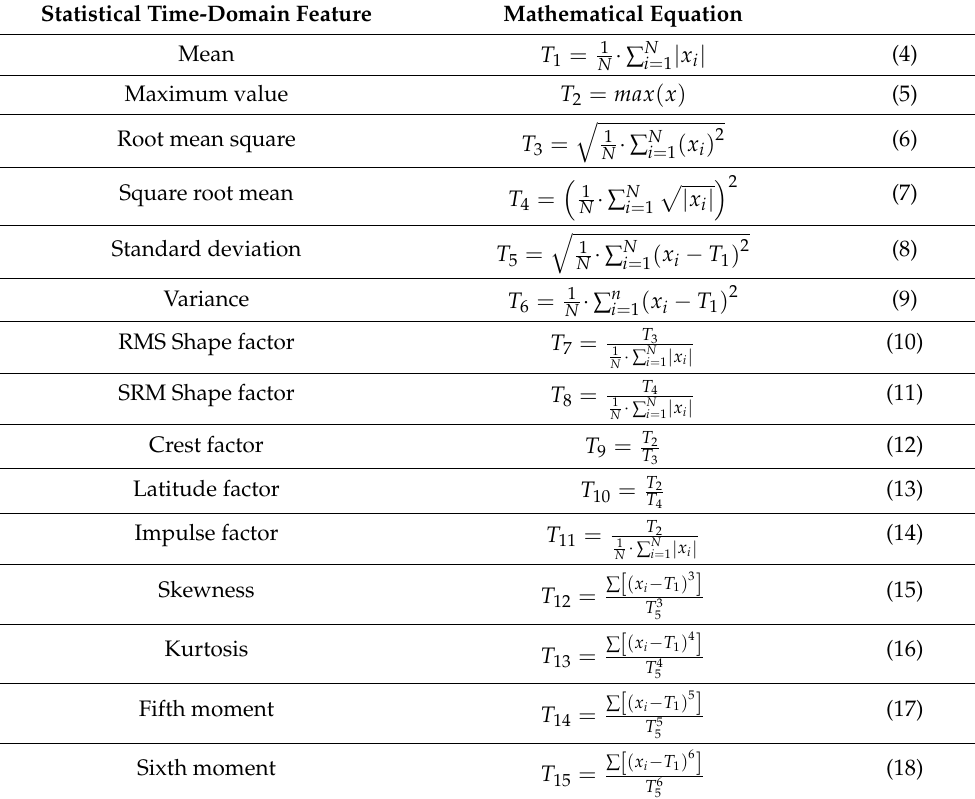
Table 1. Proposed set of statistical time-domain features for the characterization of the dynamic behavior of a